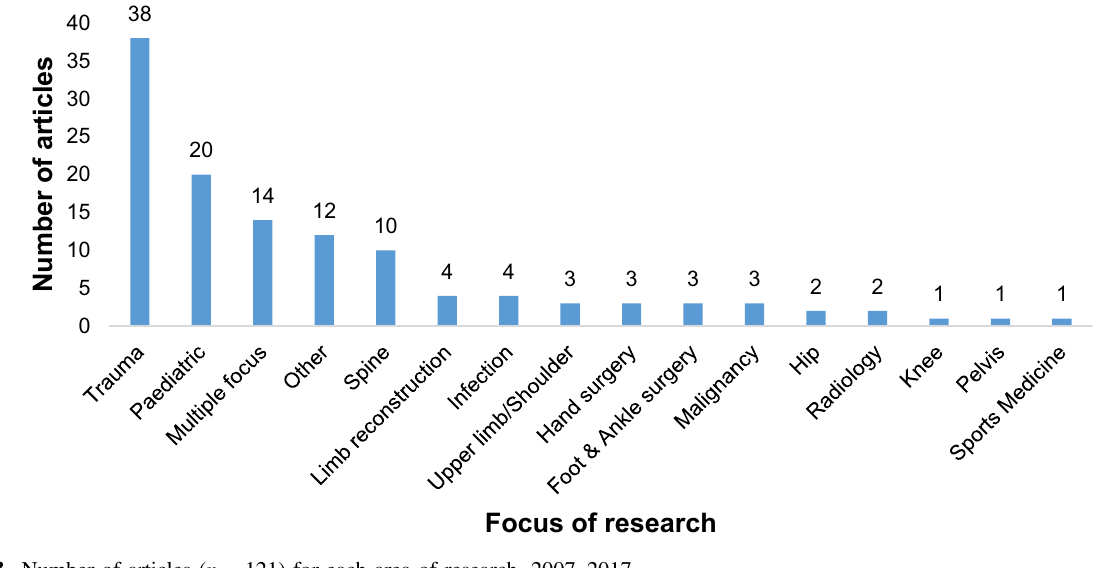
Figure 3. Number of articles ( n = 121) for each area of research, 2007 –